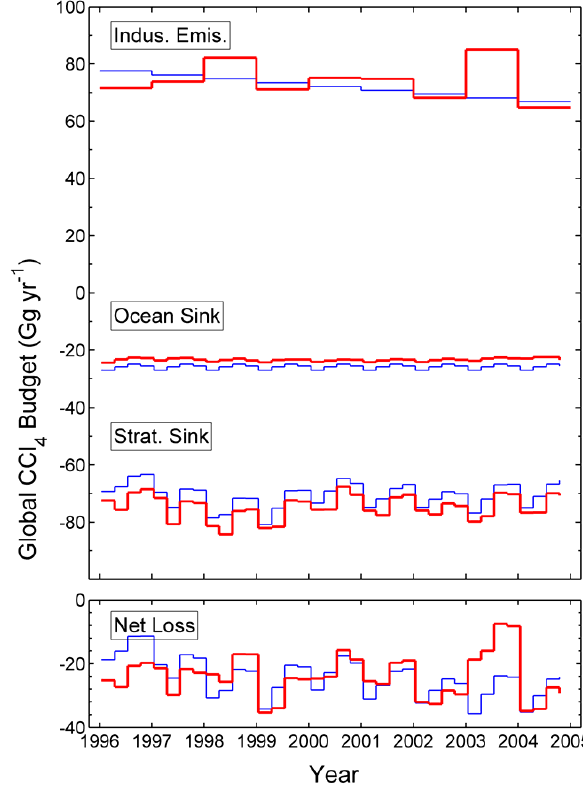
Fig. 9. Global budget of CCl 4 over the 1996-2004 period. The blue lines show the reference and the red thick lines show the optimization (error bars are not shown but are given in Fig. 6 and Table 2). Global industrial emissions, oceanic sink, and stratospheric sink are shown at one year, 3-month, and 3-month time intervals, respectively.